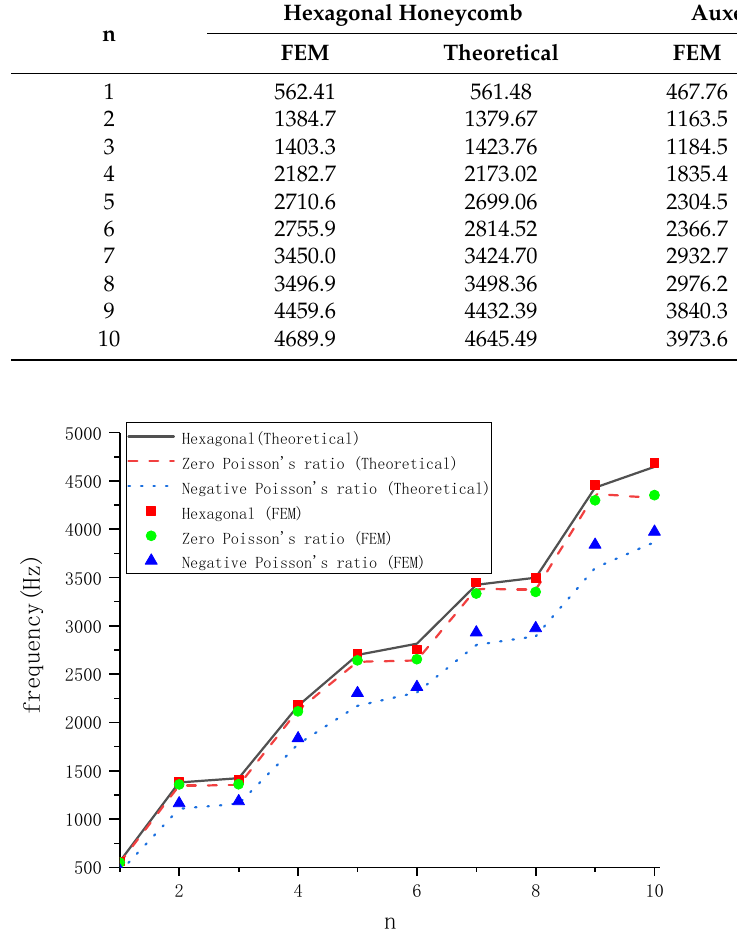
Figure 4. Comparison of the frequencies of three honeycomb sandwich plate.